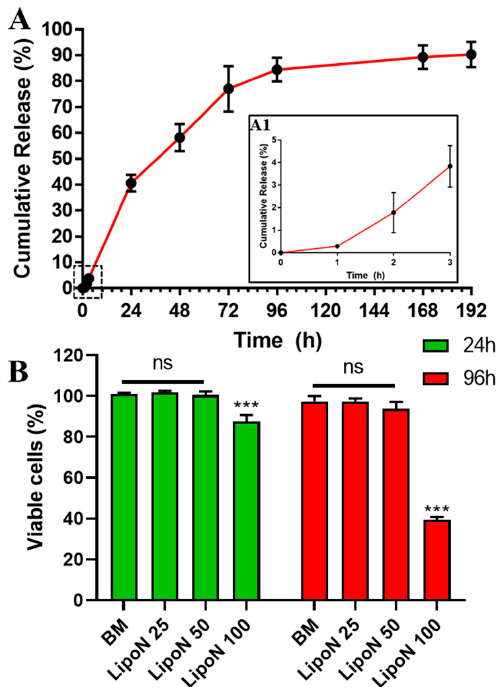
Figure 2. ( A ) Naringin-loaded nanoliposomes in vitro cumulative release profile in dPBS (pH = 7.4) at 37 °C. ( A1 ) The zoomed section representing the cumulative release during the first 3 h. Data are presented as mean ± s.d. ( n = 3). ( B ) hASCs cell viability at 24 and 96 h following incubation with basal culture medium (BM) and different naringin concentrations (25, 50, and 100 μ g mL − 1 ) loaded in nanoliposomes (LipoN, 50,). Data are represented as mean ± s.d., n = 5. The reported data were analyzed using a two-way ANOVA followed by Holm-Sidak’s test. Significance was indicated as *** ( p < 0.001).